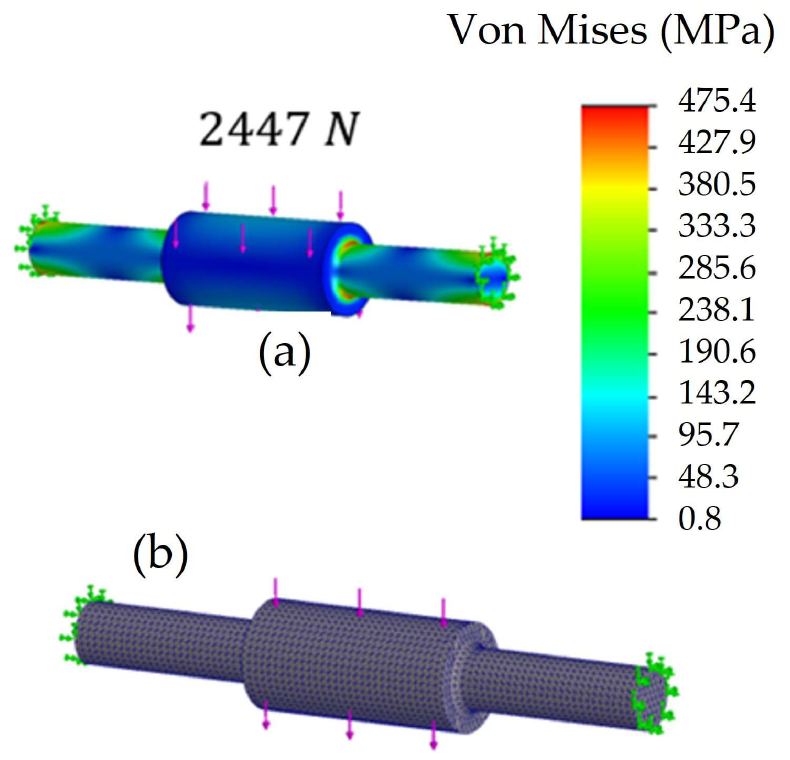
Figure 12. Lower shaft of the shock absorber: ( a ) Von Mises stress; ( b ) Mesh